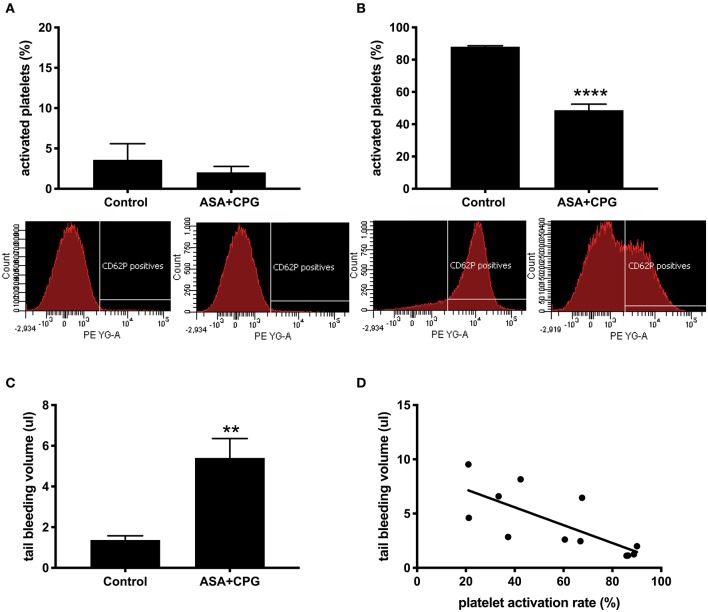
(A) Platelet activation rates in unstimulated samples: Control: 3.6 ± 2.0%, n = 12; ASA+CPG: 2.0 ± 0.7%, n = 15, p = 0.3649 with selected example images of fluorescence intensity for platelet activation marker anti-CD62P-PE in unstimulated blood samples (FACSDiva software). (B) Platelet activation rates in thrombin stimulated samples: Controls: 88.0 ± 0.6%, n = 12; ASA+CPG: 47.5 ± 3.8%, n = 15, p < 0.0001, images of anti-CD62P-PE fluorescence intensity after in vitro thrombin stimulation. (C) Blood volumes in post-stroke tail bleeding testing: Controls: 1.4 ± 0.2 μl/3 min, n = 4; ASA+CPG: 5.4 ± 0.9 μl/3 min, n = 8, p = 0.004. (D) Correlation of in vitro platelet function with in vivo tail bleeding volumes: Linear regression: R2=0.5518, y = −0.08175 (95% CI: −0.134 to −0.03)*X+8.846). Correlation: r = −0.7902, p = 0.0033, n = 12. **p < 0.01; ****p < 0.0001.